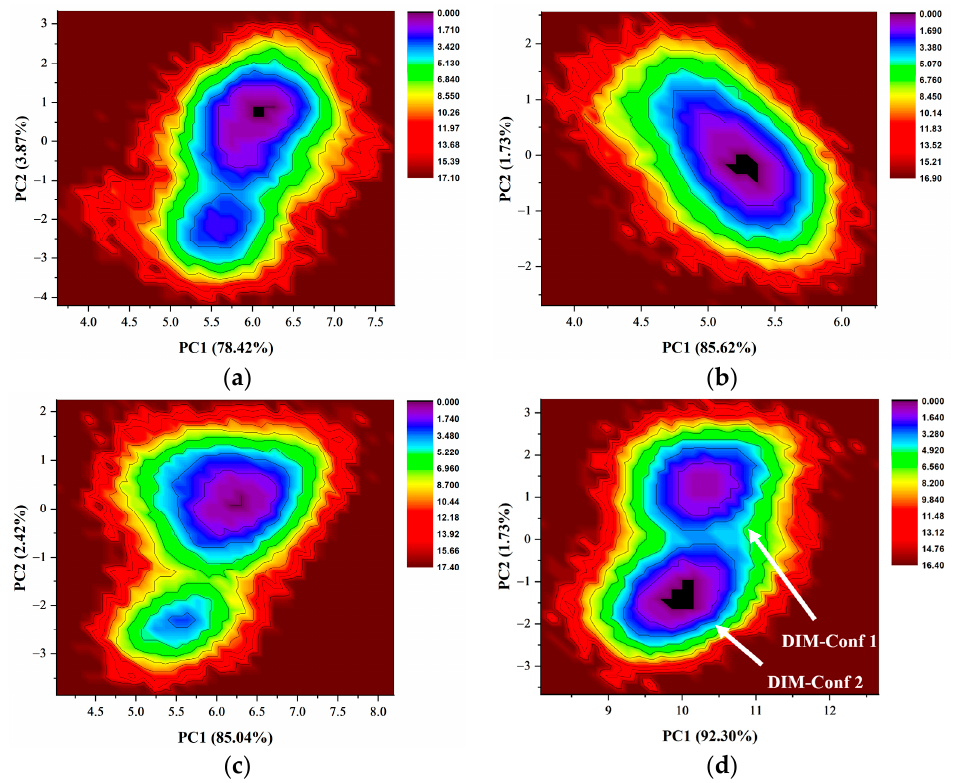
Figure 10. Free energy landscapes of the binding pocket in ( a ) the BMS-200 system, ( b ) the BMS-202 system, ( c ) the MS system, and ( d ) the Dimer system. The free energy landscapes of the residues in the binding pocket were generated by projecting the last 50 ns trajectories onto the two largest prin- cipal components (PCs), which were obtained from the diagonalization of the covariance matrices in Figure 9. The two metastable clusters of the Dimer system are named DIM-Conf 1 and 2, respec- tively. The conformation of these residues could potentially switch between the two clusters. The number in parentheses shows the percentage of the variance of PCs in the total variance. The energy of the conformation is represented by the color legend.